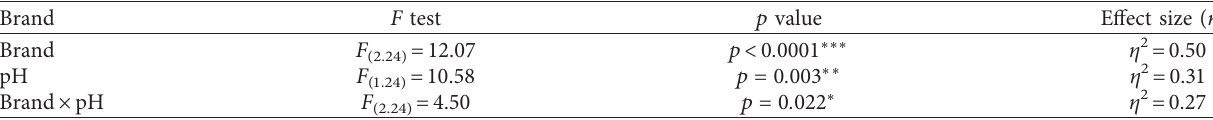
Table 4: Global tests for brand effect, pH, and brand × pH interaction.